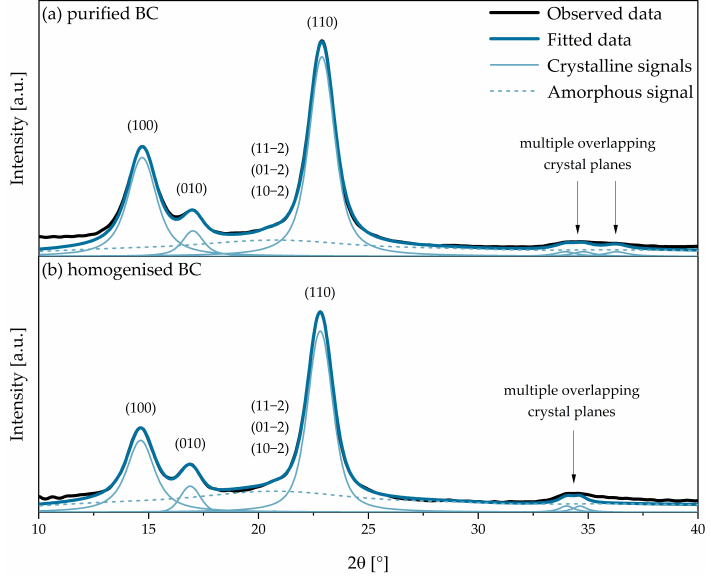
Figure 2. X-ray diffraction patterns of ( a ) purified and ( b ) homogenized bacterial cellulose (BC) with their respective crystalline and amorphous content after peak